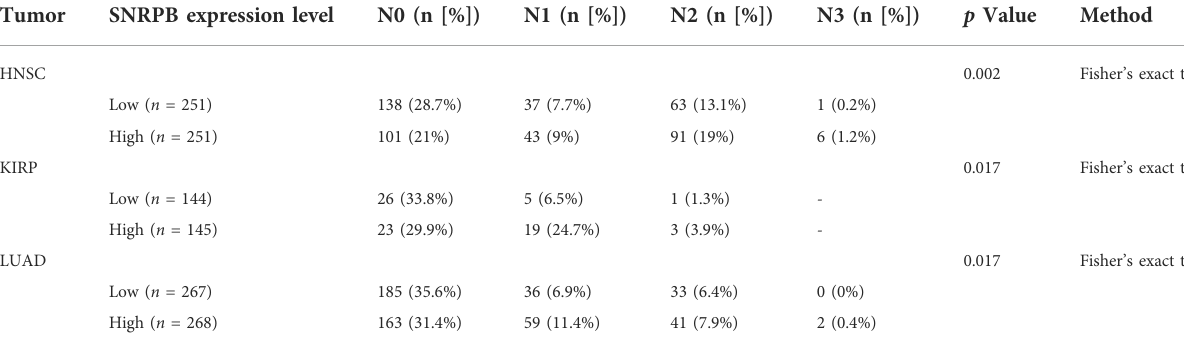
TABLE 2 The relationship between SNRPB expression and tumor N stages.